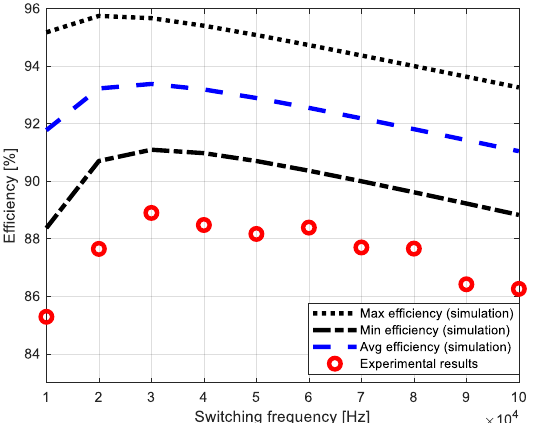
Figure 9. Comparison of simulation and experimental results for the push – pull converter efficiency with input power of 300 W.